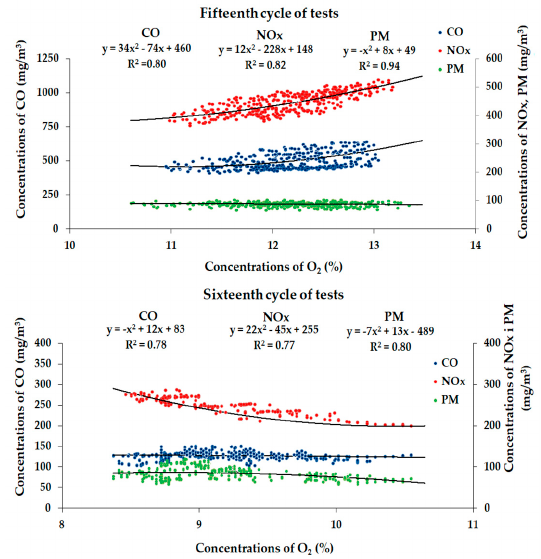
Figure 13. Mass distribution of harmful substances to the remaining amount of oxygen for the fifteenth and sixteenth cycle of tests.